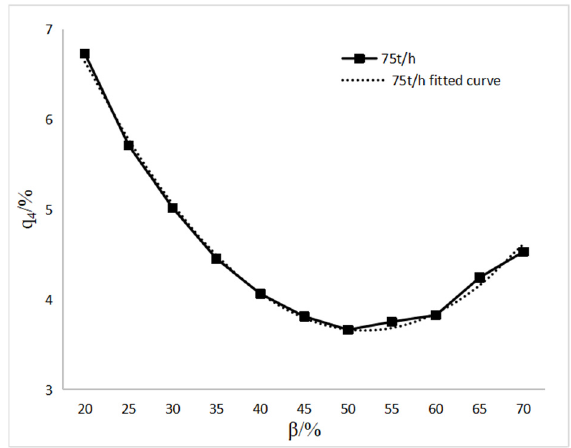
Figure 10. Influence of β on q 4 .